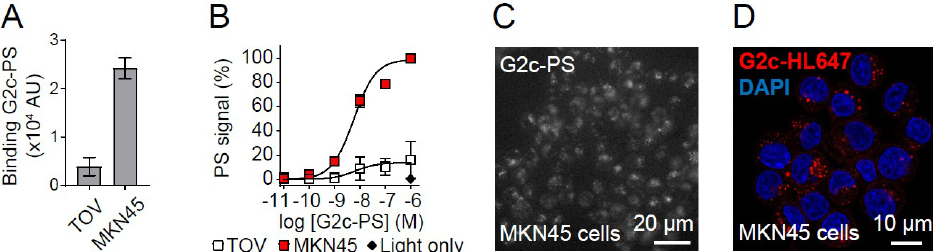
Figure 5. Met-targeting G2c-PS conjugates associate with Met-overexpressing MKN45 cells. ( A ) Binding of G2c-PS to MKN45 cells and not to TOV112D cells. Cells were incubated with 50 nM G2c-PS for 2 h on ice and PS fluorescence was detected with an Odyssey infrared scanner. Mean ± SD of n = 2 is shown. ( B ) Increased cell association of G2c-PS with MKN45 cells with increasing concentrations. MKN45 and TOV112D cells were pulsed with G2c-PS for 2 h at 37 °C. PS fluorescence was detected with an Odyssey infrared scanner. Mean ± SD of n = 3 is shown. ( C ) Association of G2c-PS in MKN45 cells. Cells were pulsed for 2 h with 1 µM of G2c-PS and imaged by wide-field fluorescent microscopy. ( D ) Uptake of G2c-HL647 in MKN45 cells. Cells were pulsed for 2 h with 1 µ M of G2c-HL647 (red) and imaged by confocal laser scanning microscopy.